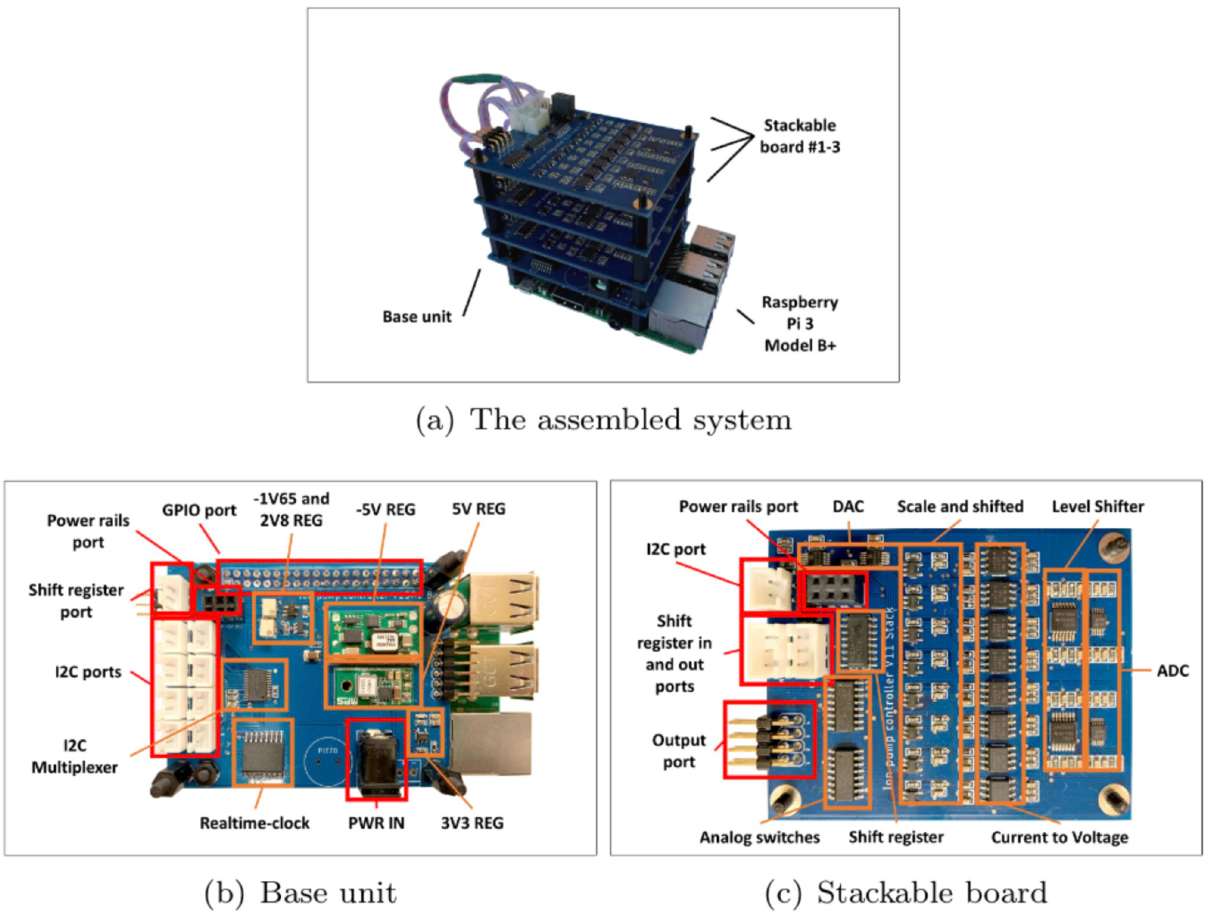
Fig 2. The multi-channel potentiostat. (A) A 24 channels assembled unite with three stackable boards (B) The base unit attached to the Raspberry Pi 3 B+ (C) Stackable board. For (B) and (C), the main electronic Integrated circuit (IC) are highlighted in Orange and connection ports are highlighted in